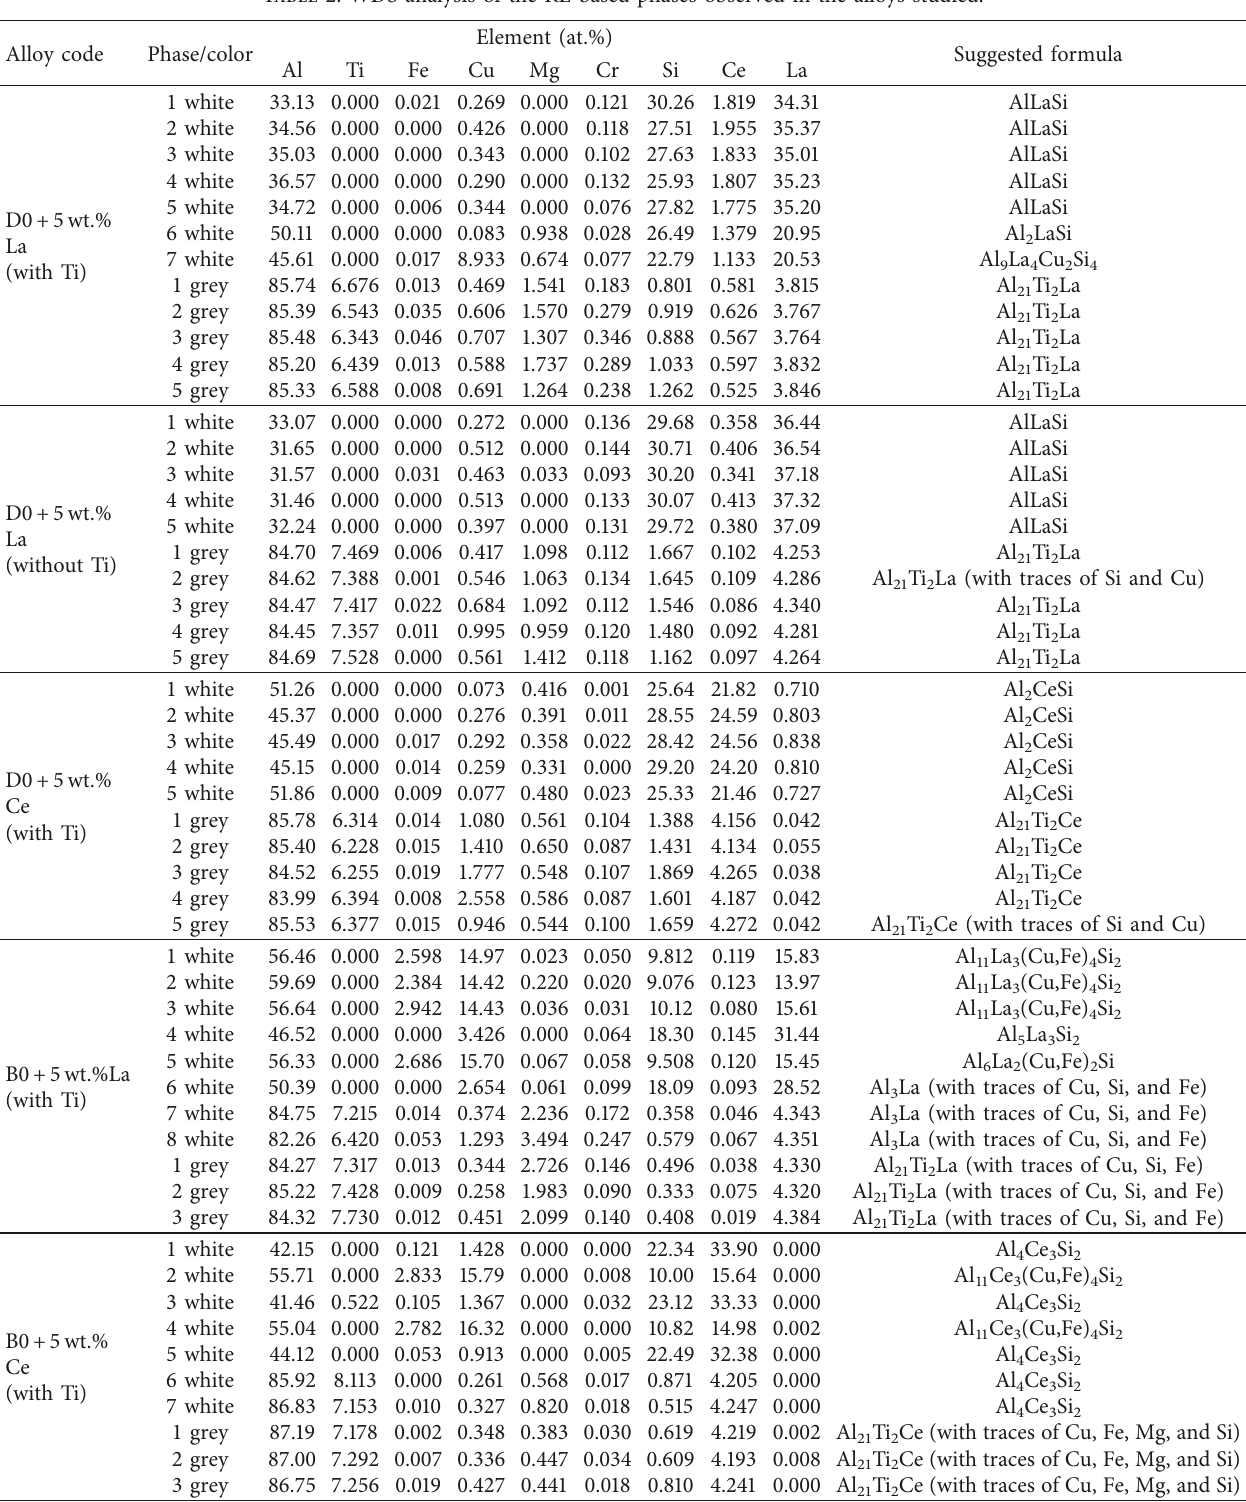
Table 2: WDS analysis of the RE-based phases observed in the alloys